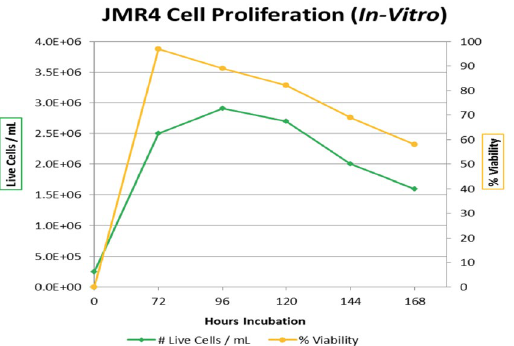
Figure 1. Time course evaluation for JMR4 mouse thymus tumor cell proliferation and cell viability (%). The mouse thymus tumor cells were incubated in cell media (without replacement) for 7 days at 10% CO 2 , > 95% relative humidity and 37 °C. Small aliquots (50 µ L) were taken for each time point measurement, with a maximum cell count/mL and viability (%) obtained after 3–5 days. The turnover time for the JMR4 mouse thymus tumor cells in the growth phase and under the stated conditions was approximately 24 hrs. Cell counting and viability (%) using trypan blue staining were measured using the Cellometer ™ Auto T4 Cell